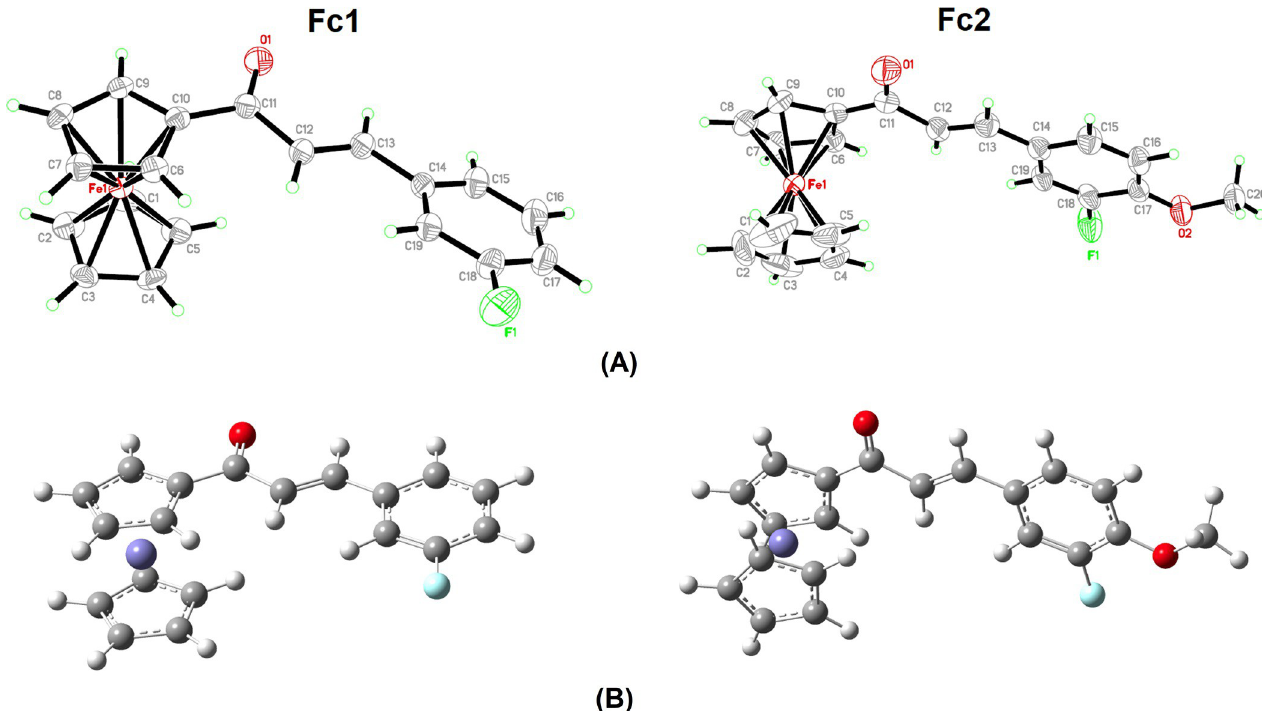
Fig 3. The molecular structure of Fc1 and Fc2. (A) ORTEP diagrams showing 50% displacement ellipsoids (B) Optimized structures using DFT/B3LYP/6- 311G++(d,p) basis set level.